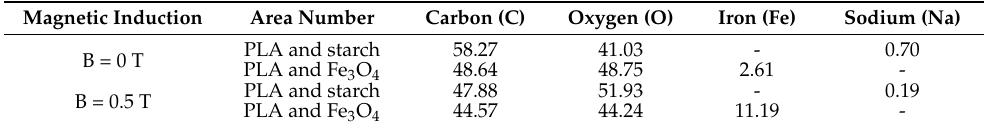
Table 5. Composition (in % by weight) of [PLA and Fe 3 O 4 (10% b.w.)] and [PLA and starch (10% b.w.)] composite surfaces formed in CMF (B = 0.5 T) and without a magnetic field (B = 0 T).